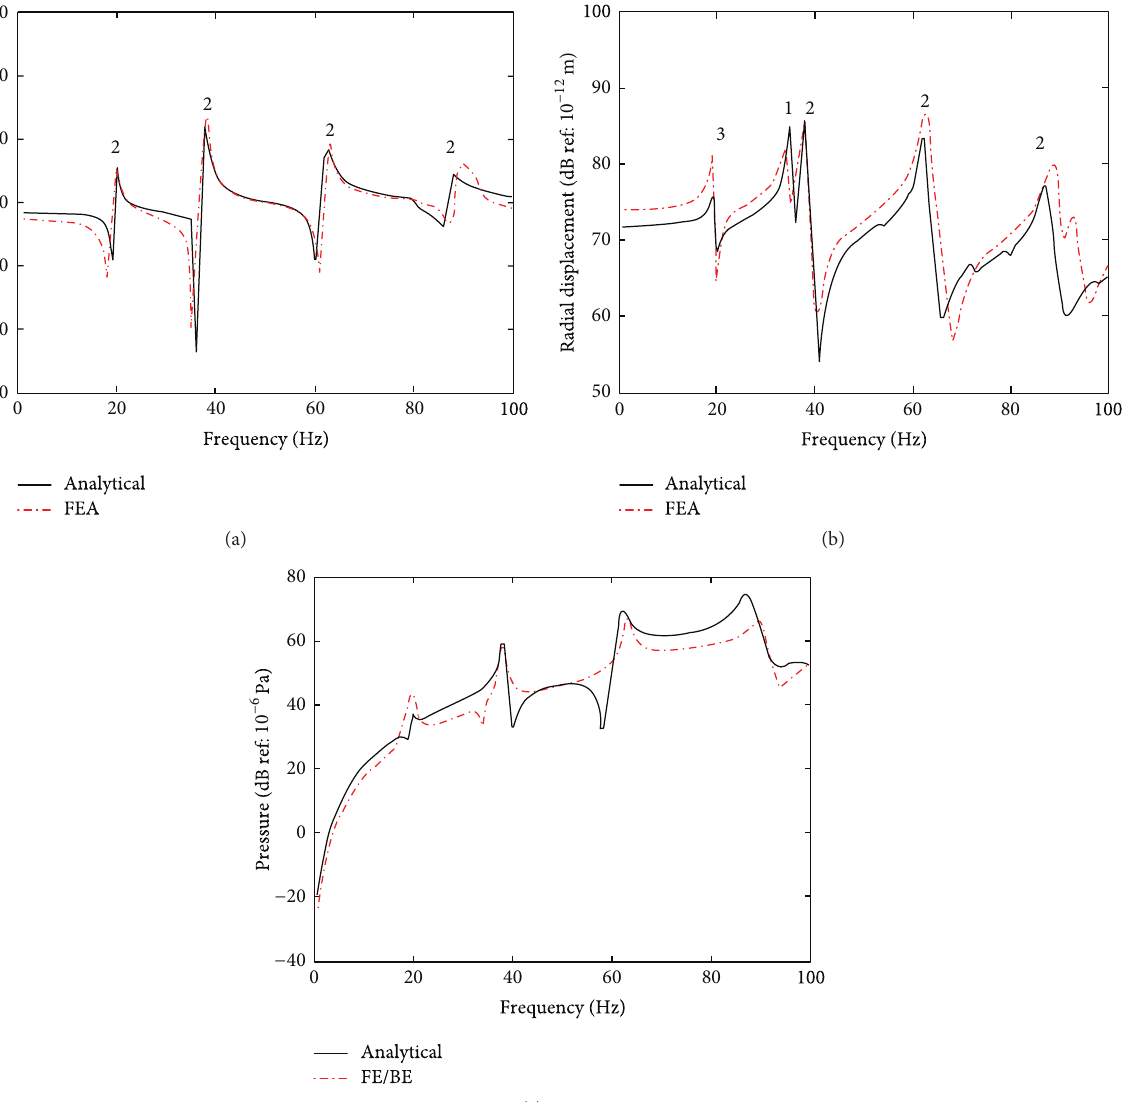
Figure 9: Structural and acoustic responses due to 𝐹 1 (a) axial displacement, (b) radial displacement, and (c) far-field pressure.